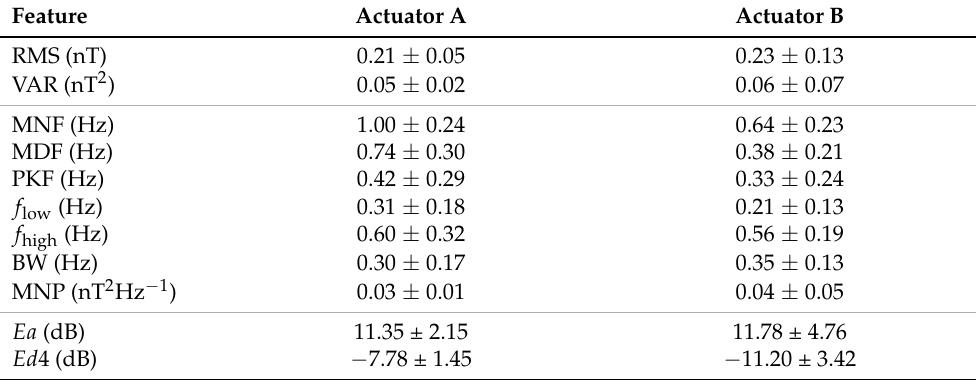
Table 4. Features obtained in the dual actuator experiment with water for Subject “b”. Values provided in mean standard deviation. Domains are separated by grey ±